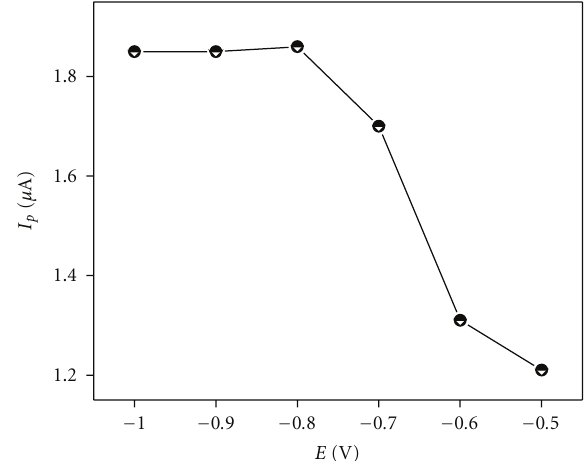
Figure 2: E ff ects of deposition potential on DPV peak currents for 5 × 10 − 7 moL of Hg 2+ at AAP modified GC electrode. Electrolyte: 0.1 mol L − 1 HAc + 0.1 mol L − 1 NaCl (pH 7.0) solution. GC electrode modified with 0.063 µ mol AAP, t d : 10